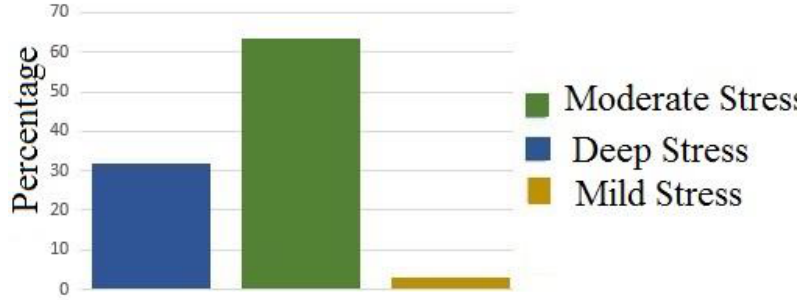
Figure 19. Level of stress in the study population.